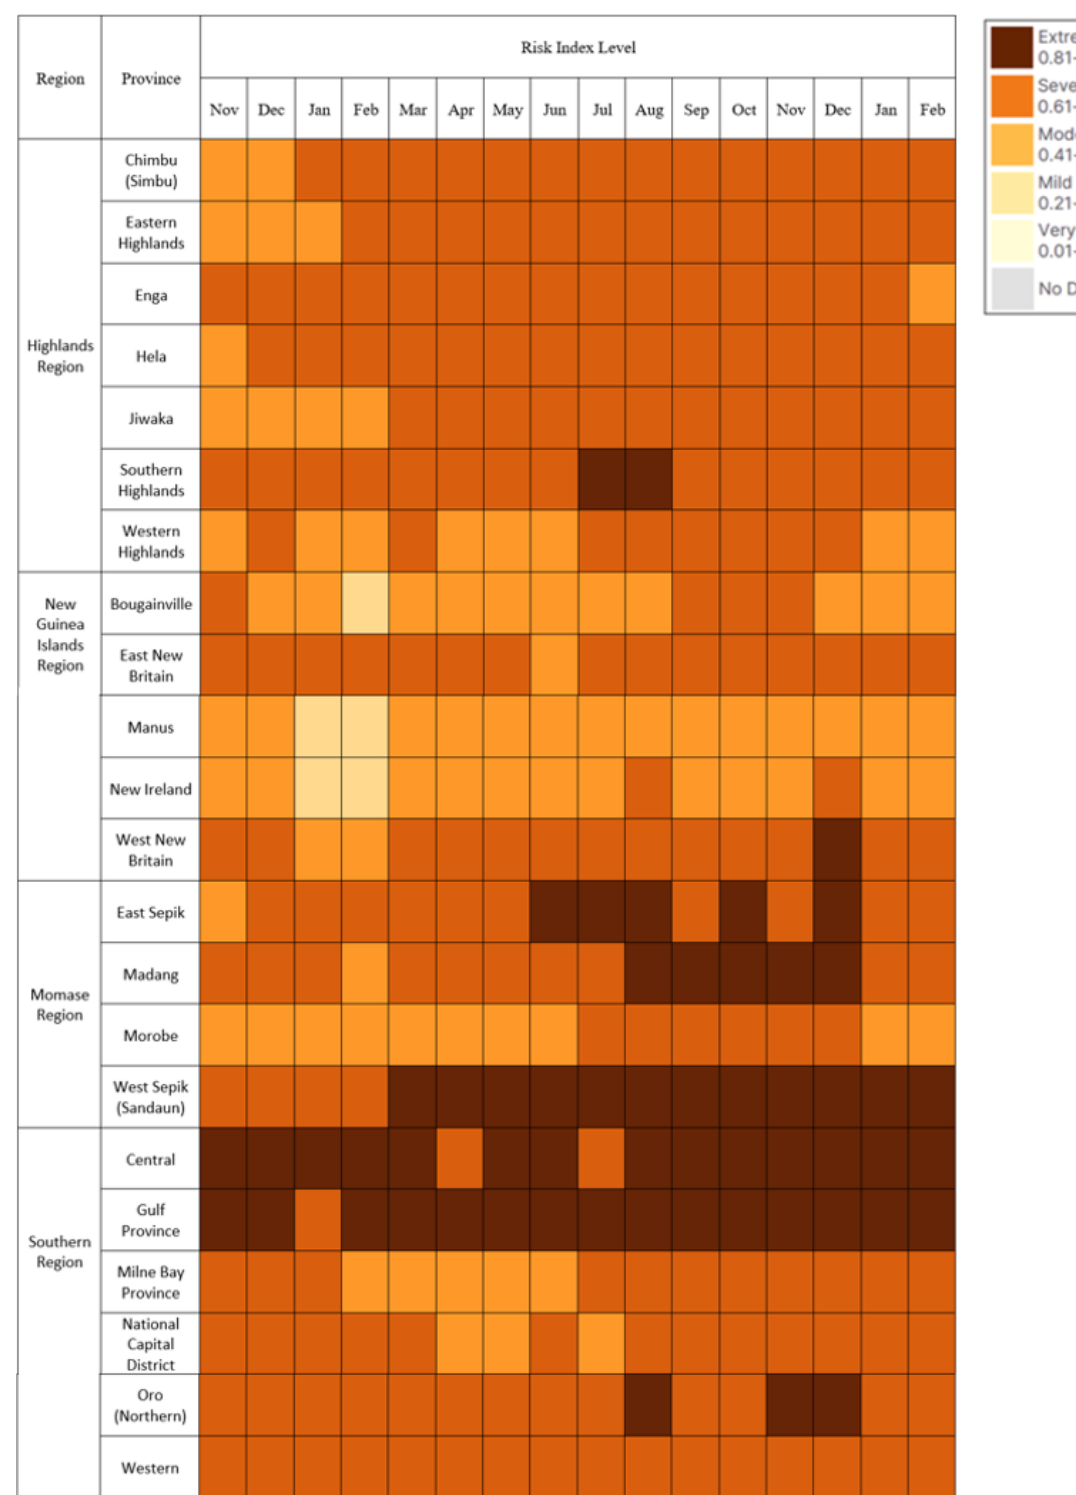
Figure 10. Drought risk levels calculated from monthly risk assessments for each province during the transition into the strong 2015–2016 drought conditions. Drought risk levels are given for November and December 2014, January to December 2015, and January and February 2016. The drought risk level is classified on a deepening orange colour scale from mild (index values from 0.01–0.25) to extreme (index values from